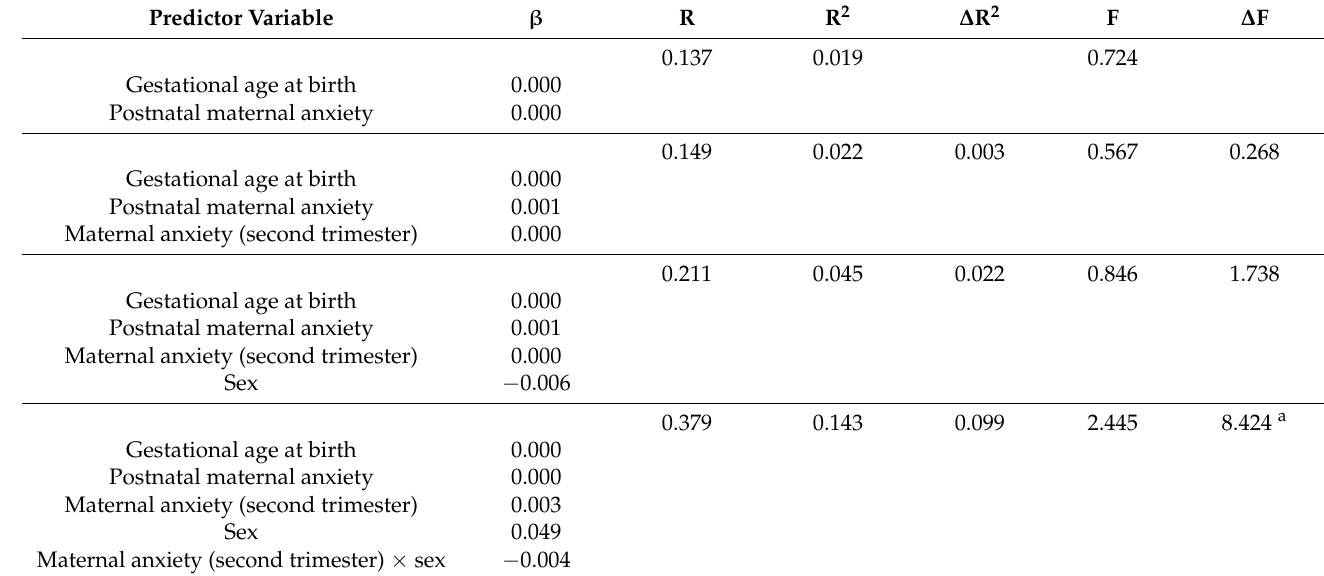
Table 6. Linear regression model of methylation level of LINE1